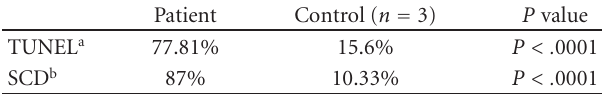
Table 1: Percentages of sperm with DNA fragmentation in semen of a heterochromatin polymorphism carrier and control group of fertile donors.